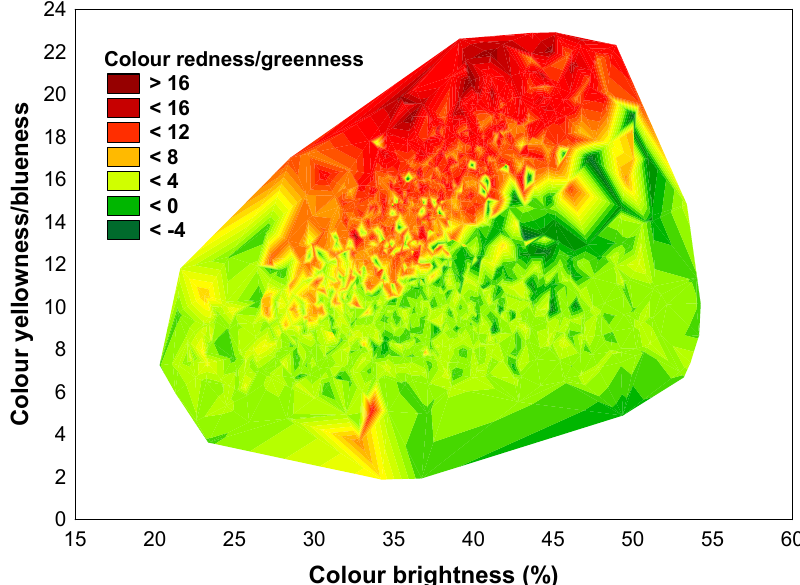
Figure 4. The spectrum of bark colours in the measured spruce trees.